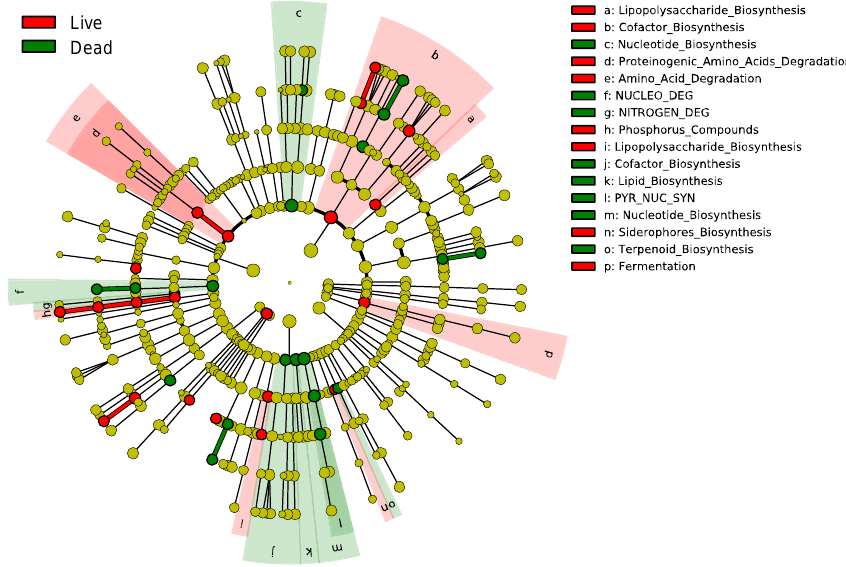
Figure 4. Cladogram representation of differentially abundant predicted MetaCyc pathway ontolo- gies of bacterial communities between live and dead trees. MetaCyc pathway abundance were predicted using PICRUSt2. The overlap of MetaCyc pathways are classified by the MetaCyc pathway ontologies. Differentially abundant MetaCyc pathway ontologies were analyzed using LEfSe with linear discriminant analysis (LDA) score > 3.0 and a p < 0.05.